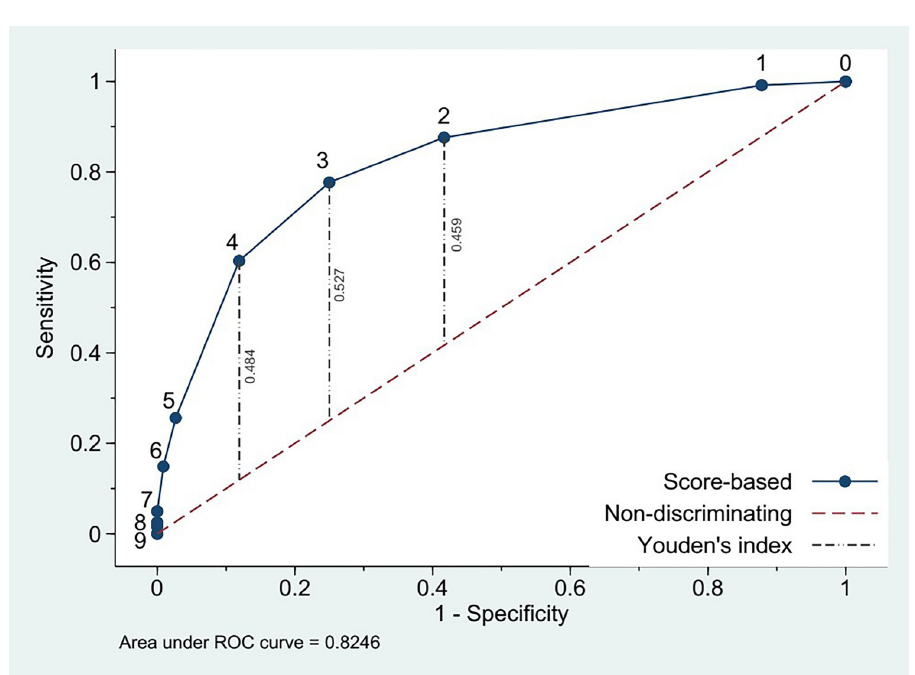
Fig 2. Receiver operating characteristic curve of model-based scores. Youden’s index maximizing summation of sensitivity and specificity and calculated as “sensitivity–(1 –specificity)” was shown for scores 2, 3 and 4, respectively; ROC, receiver operating